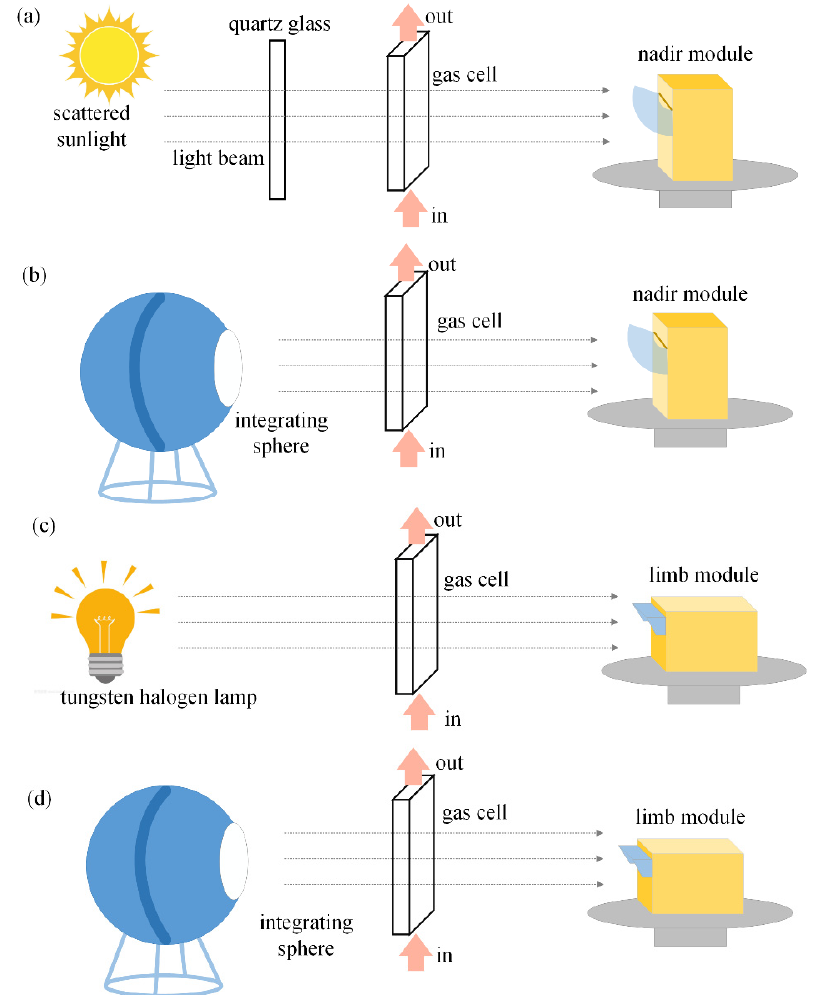
Figure 3. Schematic of the EMI-NL NO 2 sample gas measurement experimental setup. ( a ) EMI-NL nadir module measurements with the scattered sunlight; ( b ) EMI-NL nadir module measurements with the integrating sphere; ( c ) EMI-NL limb module measurements with the tungsten halogen lamp; ( d ) EMI-NL limb module measurements with integrating sphere.